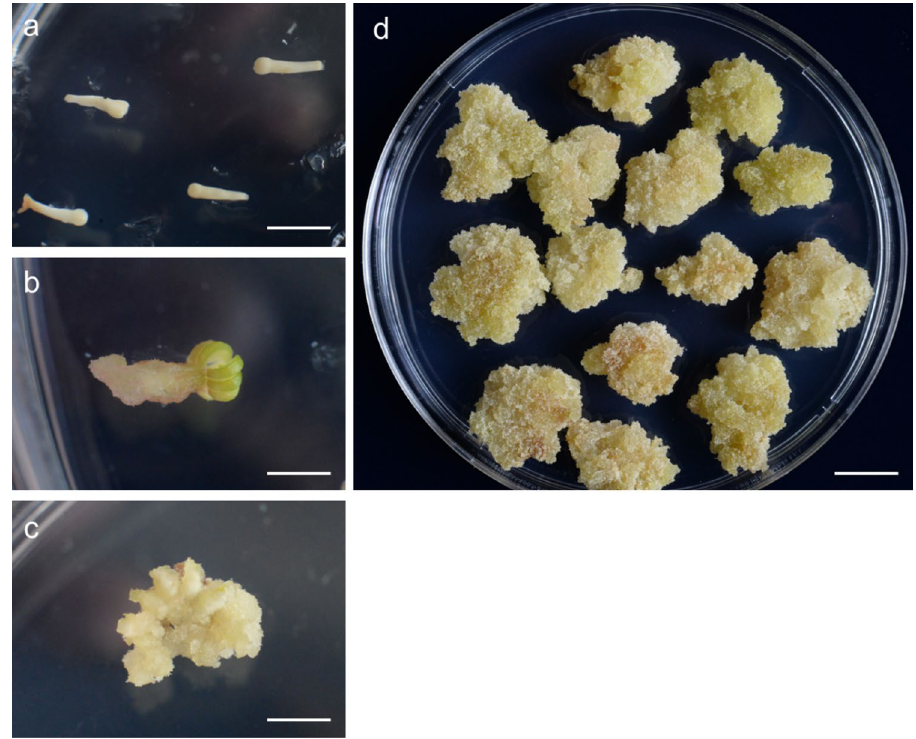
Figure 1. Induction and proliferation of calli from mature zygotic embryo culture on 1/2 LV medium with 1 mg/L 2,4-D and 0.5 mg/L BA. ( a ) Culture of mature zygotic embryos of P. strobus. ( b ). Induction of calli on the surfaces of zygotic embryos after two weeks of culture. ( c ) Callus induction after subculture on new 1/2 LV medium with 1 mg/L 2,4-D and 0.5 mg/L BA. ( d ) Actively proliferated calli on 1/2 LV medium with 1 mg/L 2,4-D and 0.5 mg/L BA after 4 weeks of culture. Bar in ( a) = 4 mm. Bar in ( b ) = 2 mm. Bar in ( c ) = 2 mm. Bar in ( a ) = 15